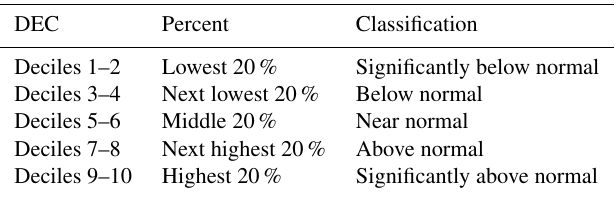
Table 5. Classification of drought conditions according to the values of the